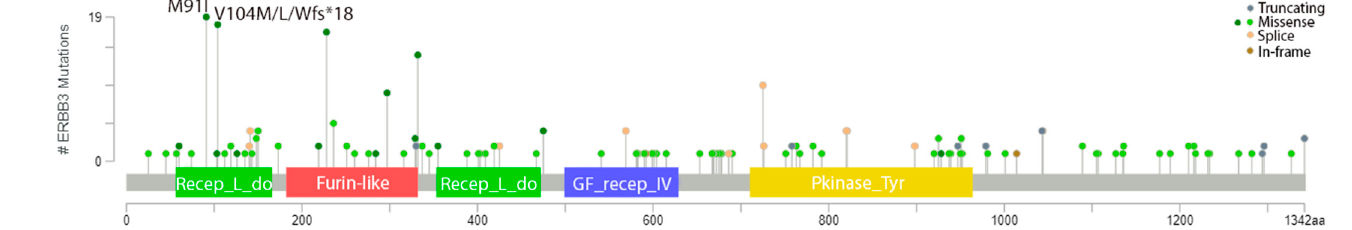
Figure 3. The frequency of HER3 mutations in bladder cancer and their locations within the receptor. Figure rendered in cBioPortal using multiple studies (n = 2419). Gray indicates truncating mutation, green indicates a missense mutation, yellow indicates splice mutation, and brown indicates an in-frame mutation [27,28] .